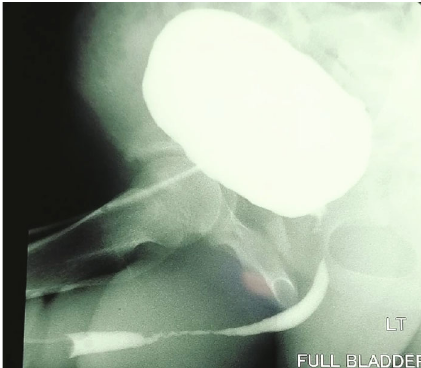
Figure 1: RUG in the left oblique view showing a 7 cm long partial occlusion of the penile and bulbar urethra.